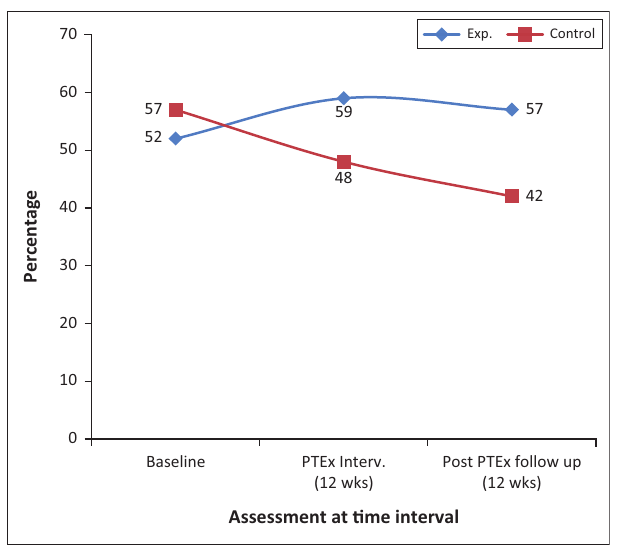
FIGURE 6: The percentages of participants with normal or minimally ankle tendon reflex at baseline, 12 and 24 weeks, in the intervention and control groups. Exp.